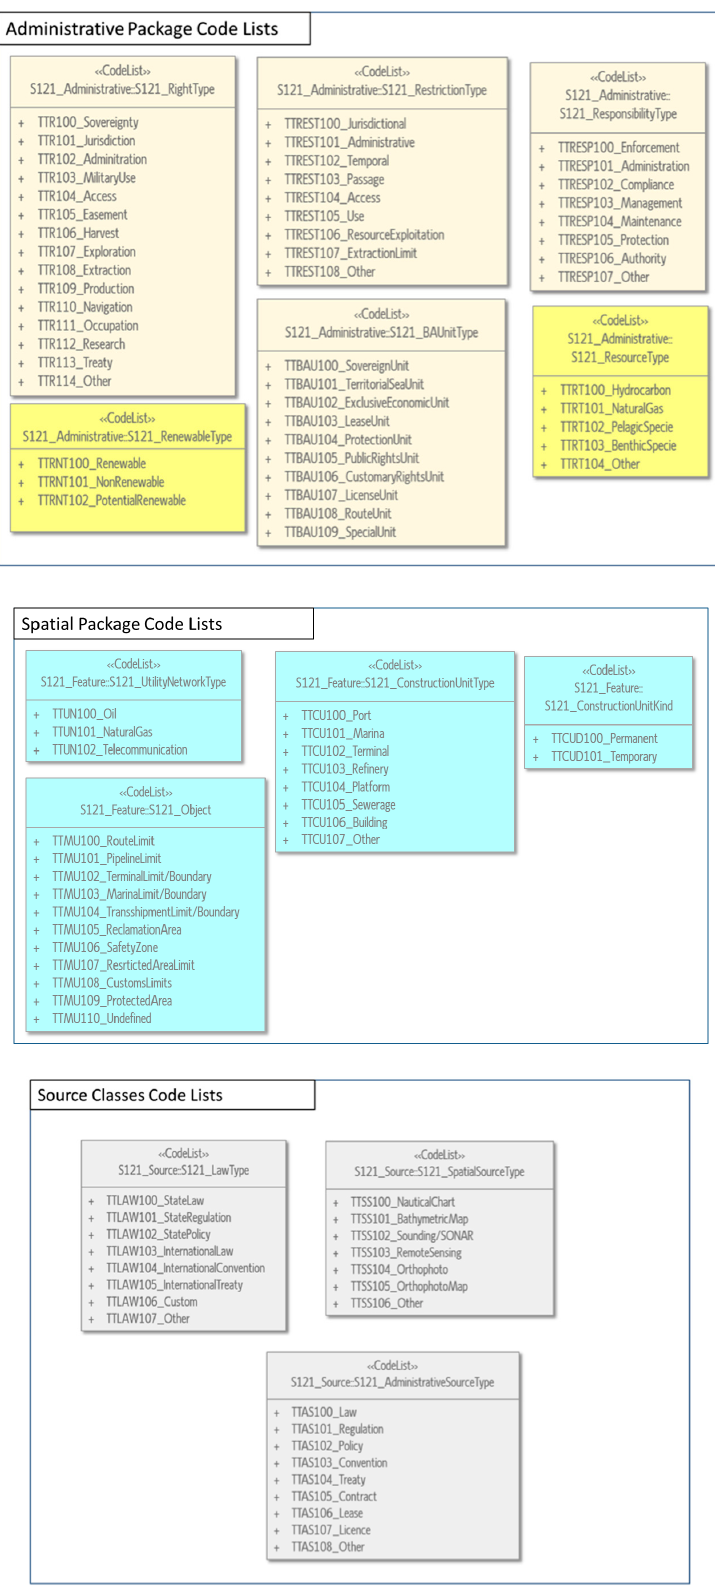
Figure 13. Code Lists for S121 Party, S121 Administrative, S121 Spatial Packages and Source Classes for Trinidad and Tobago.